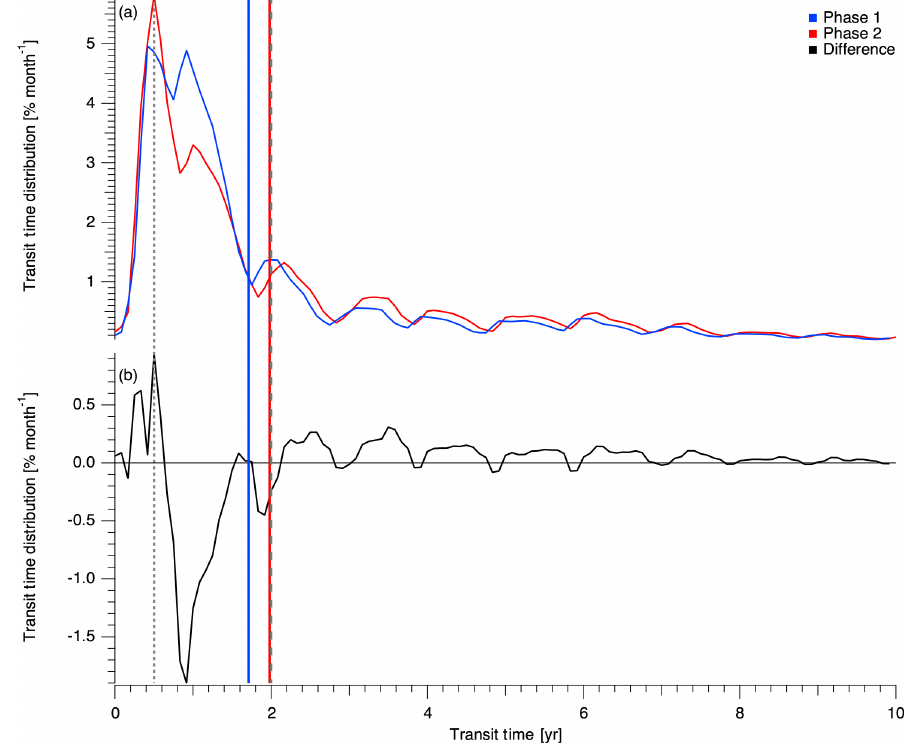
Figure 10. (a) Averaged age spectra simulated by CLaMS for phase 1 (blue) and phase 2 (red). These spectra represent the mean of the individual age spectra available for each data point along the flight track. The mean age is indicated by the respective coloured vertical lines (phase 1: 1.71 years, phase 2: 1.98 years). The difference between the spectra is given in panel (b) , showing an enhancement of young and old air masses from phase 1 to phase 2. Vertical dashed lines indicate the transit times of 6 months and 24 months (see next figures). The bin size of a data point is 1